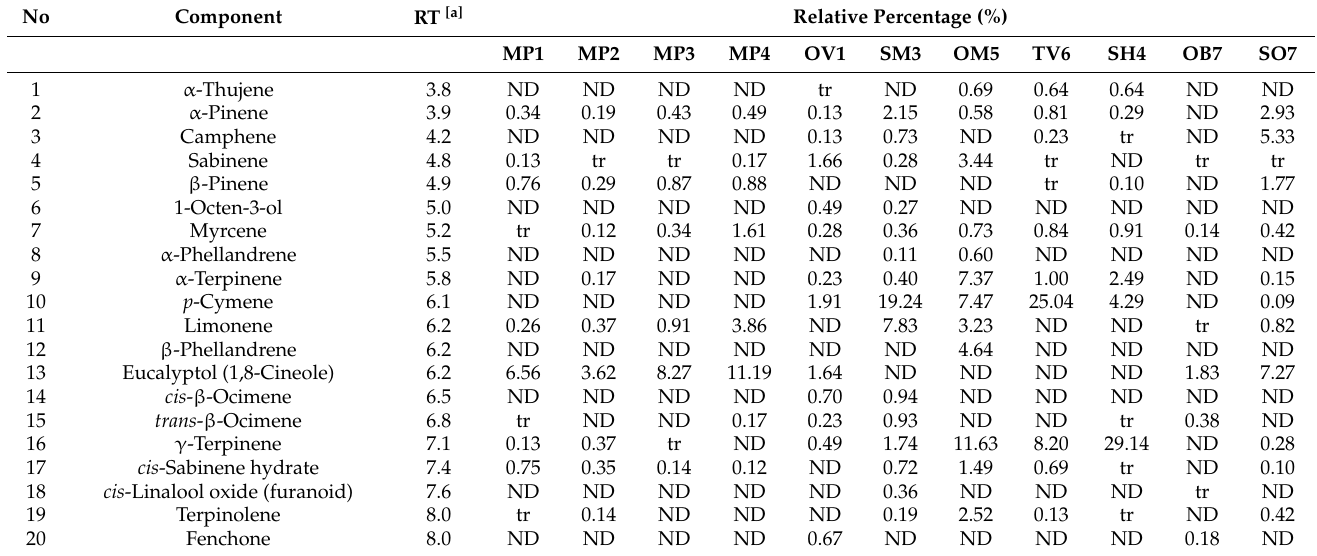
Table 2. GC-MS profile of EOs obtained from Lamiaceae